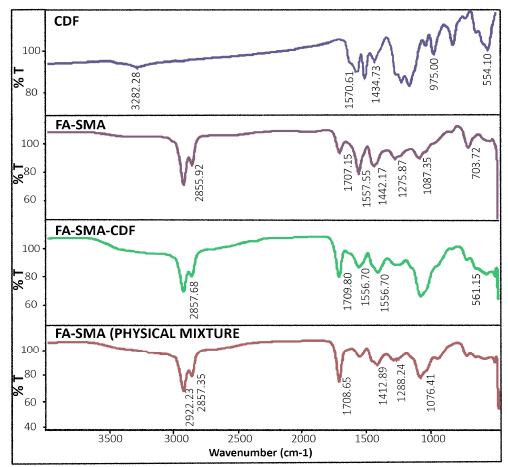
Figure 2. Up : 1 H NMR was performed for (a) folic acid, (b) FA-SMA and FA-SMA-CDF; Bottom : FTIR and characterization of CDF, FA, SMA and the FA-SMA conjugate.